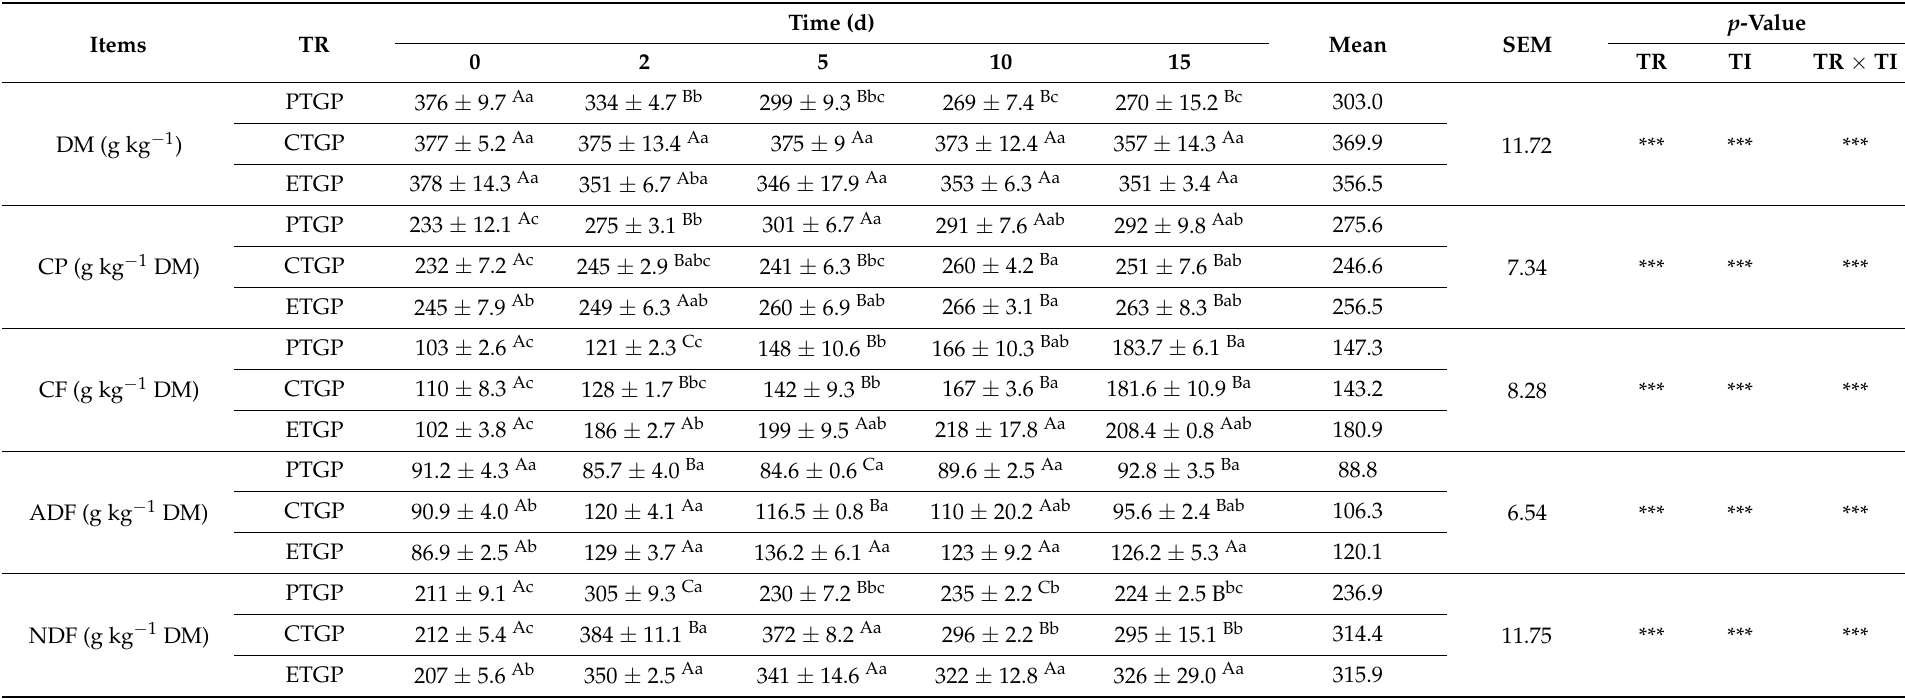
Table 3. Effect of exogenous additives and fermentation time on the chemical composition of fermented